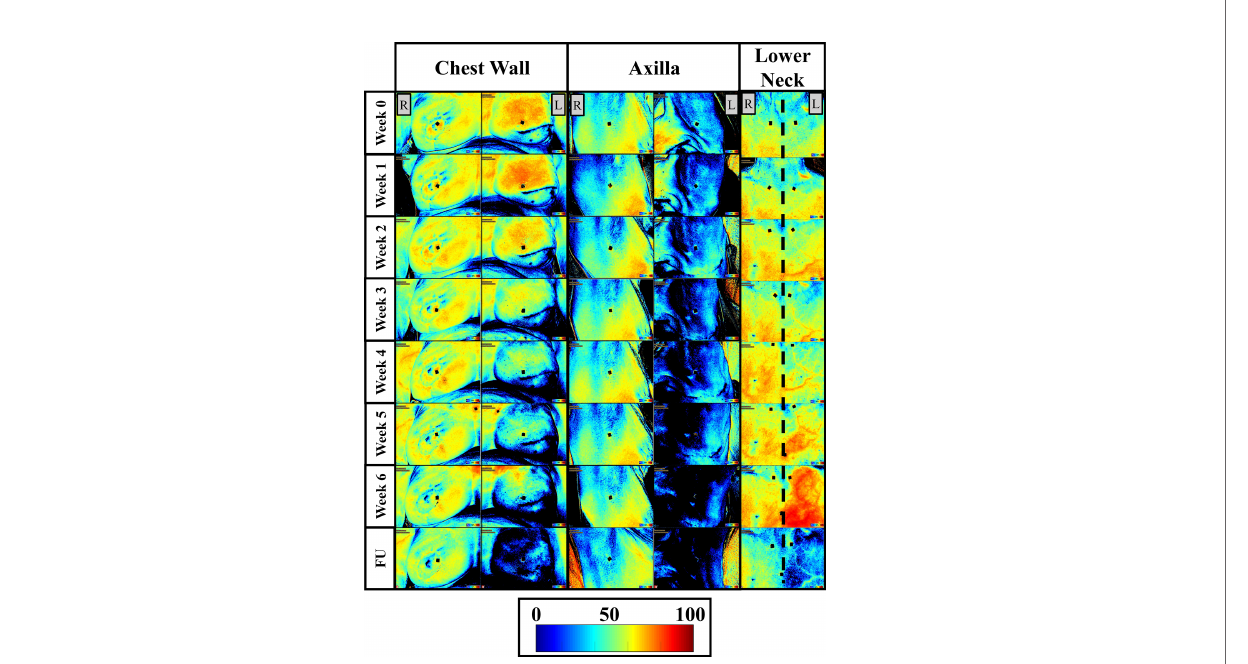
FIGURE 2 | Two-dimensional pseudo color maps of StO 2 of the ipsilateral (L) and contralateral (R) chest wall, axilla, and lower neck across weeks of RT and a follow-up (FU) after RT fi nished (1-month FU) for patient 2. Week 0 was acquired before any RT was carried out and is considered the baseline/reference image. Colorbar represents the percentage of StO 2 ranging from